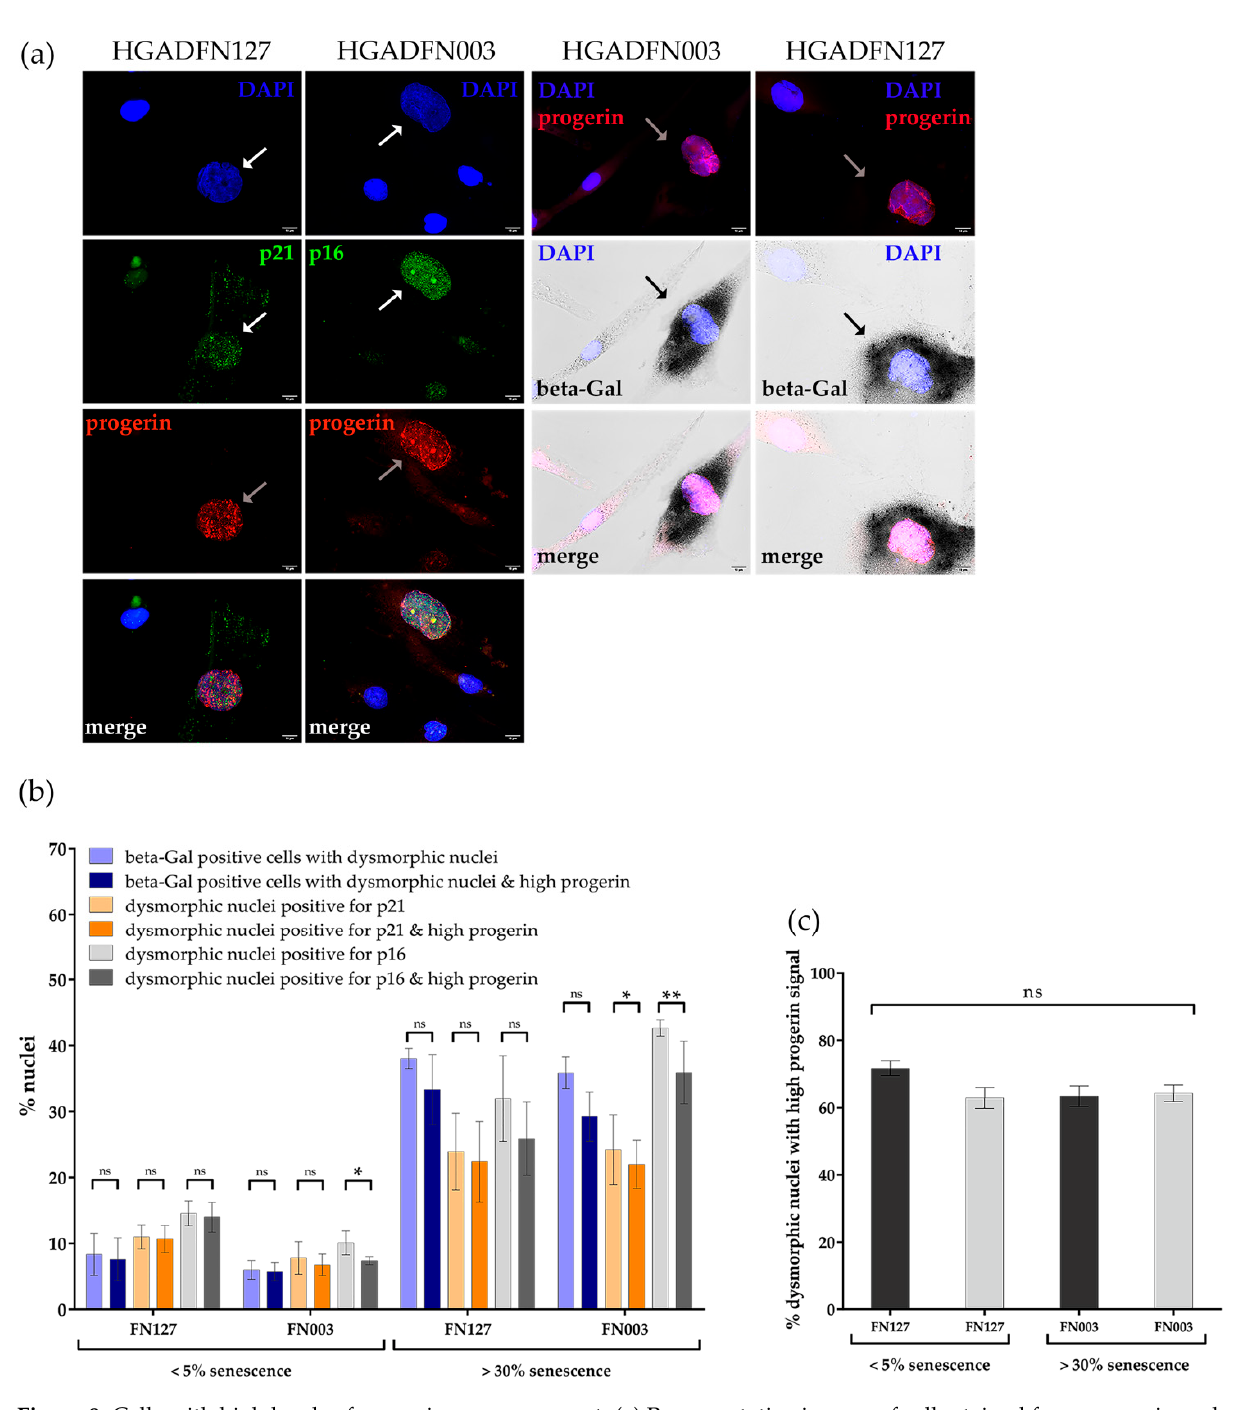
Figure 8. Cells with high levels of progerin were senescent. ( a ) Representative images of cells stained for α -progerin and α -p16/p21 or β -Gal, counterstained with DAPI. Arrows indicate nuclei with a high progerin signal and positive for either high p16 or p21 or beta-Gal. ( b ) The number of dysmorphic nuclei with strong progerin signal positive for SA- β -Gal and positive for p16 or p21 increased during replicative senescence. ( c ) The number of dysmorphic nuclei with strong progerin signal remained constant during replicative senescence. At 5% senescence, HGPS cells had a passage number ≤ P18 and at 30% senescence ≥ P21. Values are presented as mean ± SD (n ≥ 3), not significant (ns) p > 0.05, * p < 0.05, ** p < 0.01, ( b , c ) unpaired t -test, ( c ) one-way ANOVA with Tukey’s multiple comparison test. A majority of HGPS cells exhibiting a bright progerin-positive signal harbored p21, p16 and SA- β -Gal positive signals (Figure 8a). We further assessed the percentage of HGPS cells presenting a progerin-positive signal and senescence-positive markers (p21,